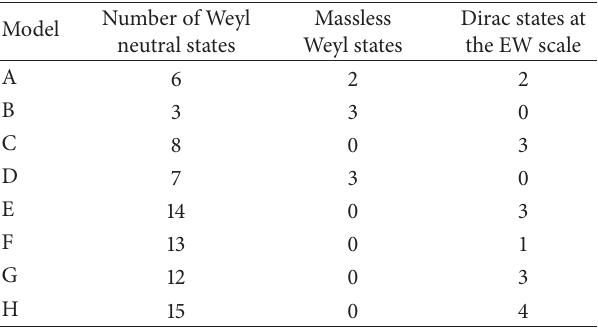
Table 2: Tree level neutrinos